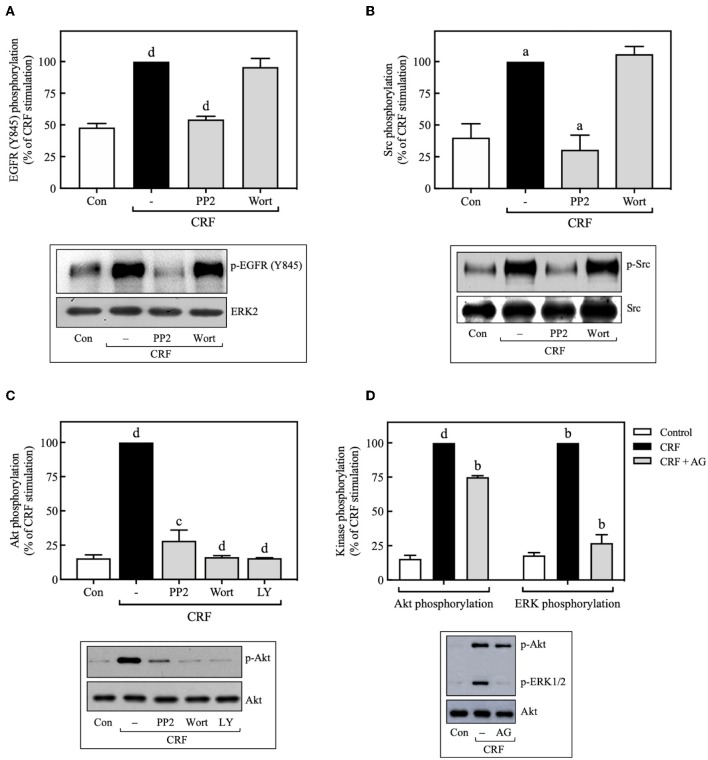
Src is an upstream regulator of EGFR and PI3K. COS-7 cells expressing HA-CRF1Rs were pretreated with 10 μM PP2, 100 nM wortmannin (Wort) (A–C) or 10 μM LY294002 (LY) (C) for 30 min, before stimulation with 100 nM CRF for 5 min. (D) Effect of 100 nM AG1478 (AG) on CRF- (100 nM, 5 min) induced ERK1/2 and Akt phosphorylation. Total cell lysates were separated by SDS-PAGE and analyzed by immunoblotting with anti-p-EGFR Tyr845
(A), anti-p-Src Tyr416
(B), anti-p-Akt Ser473
(C,D) or anti-p-ERK1/2 Thr202/Tyr204
(D), as described in Materials and Methods. EGFR, Src, Akt, and ERK1/2 phosphorylation were quantitated by densitometry, and mean values were plotted from three to five independent experiments. Vertical lines represent the S.E.M. Western blots were also probed for total ERK, Src or Akt showing equal loading. (A)
dp < 0.0001 vs. Con; dp < 0.0001 vs. CRF (–). (B)
ap < 0.05 vs. Con; ap < 0.05 CRF(–). (C)
dp < 0.0001 vs. Con; cp < 0.001, dp < 0.0001 vs. CRF (–). (D)
dp < 0.0001 vs. Con (p-Akt), bp < 0.01 vs. CRF (p-Akt); bp < 0.01 vs. Con (p-ERK), bp < 0.01 vs. CRF (p-ERK).